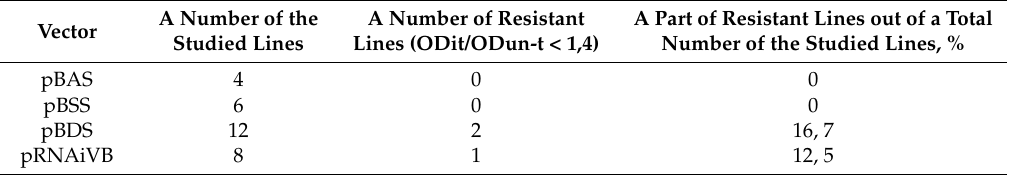
Table 1. Results of CVB resistance assay of transgenic chrysanthemum lines transformed with different